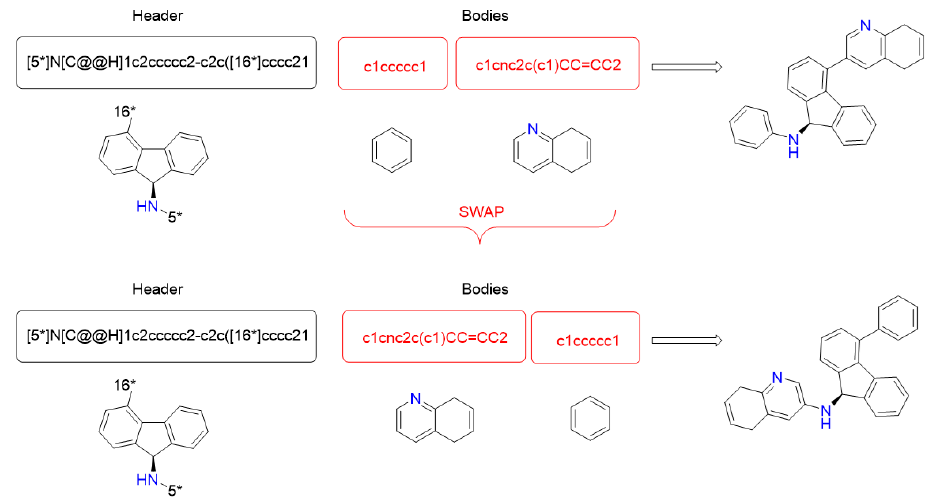
Figure 6. Swap movement